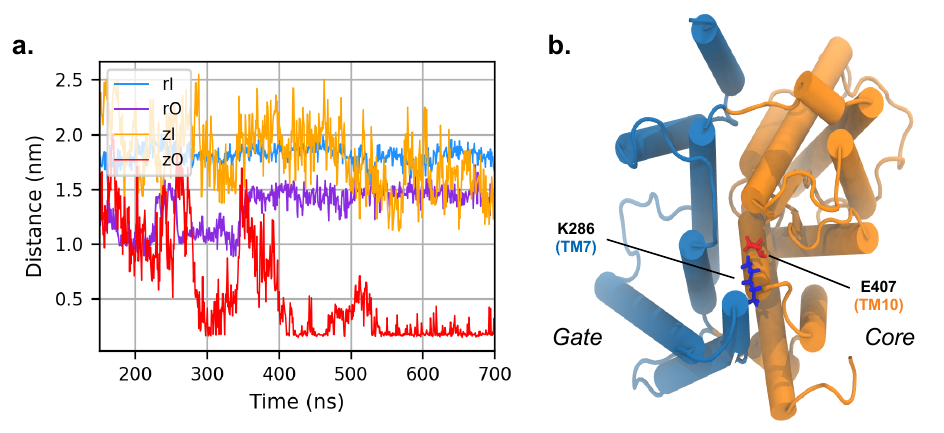
Figure 8. ( a ) Distance between K286 and E407 during the simulation of zPres and rPres (in the latter case, the corresponding residues are K283 and E404). ( b ) Cytoplasmic view of the zO; E407 is in red and K286 in blue. The core and gate domains are highlighted in orange and light blue,